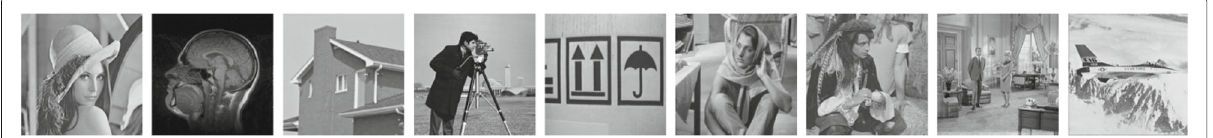
Fig. 1 Test images for experiments 1 and 2: Lena, MRI-head, house, cameraman, pattern, Barbara, man, couple, plane (from left to